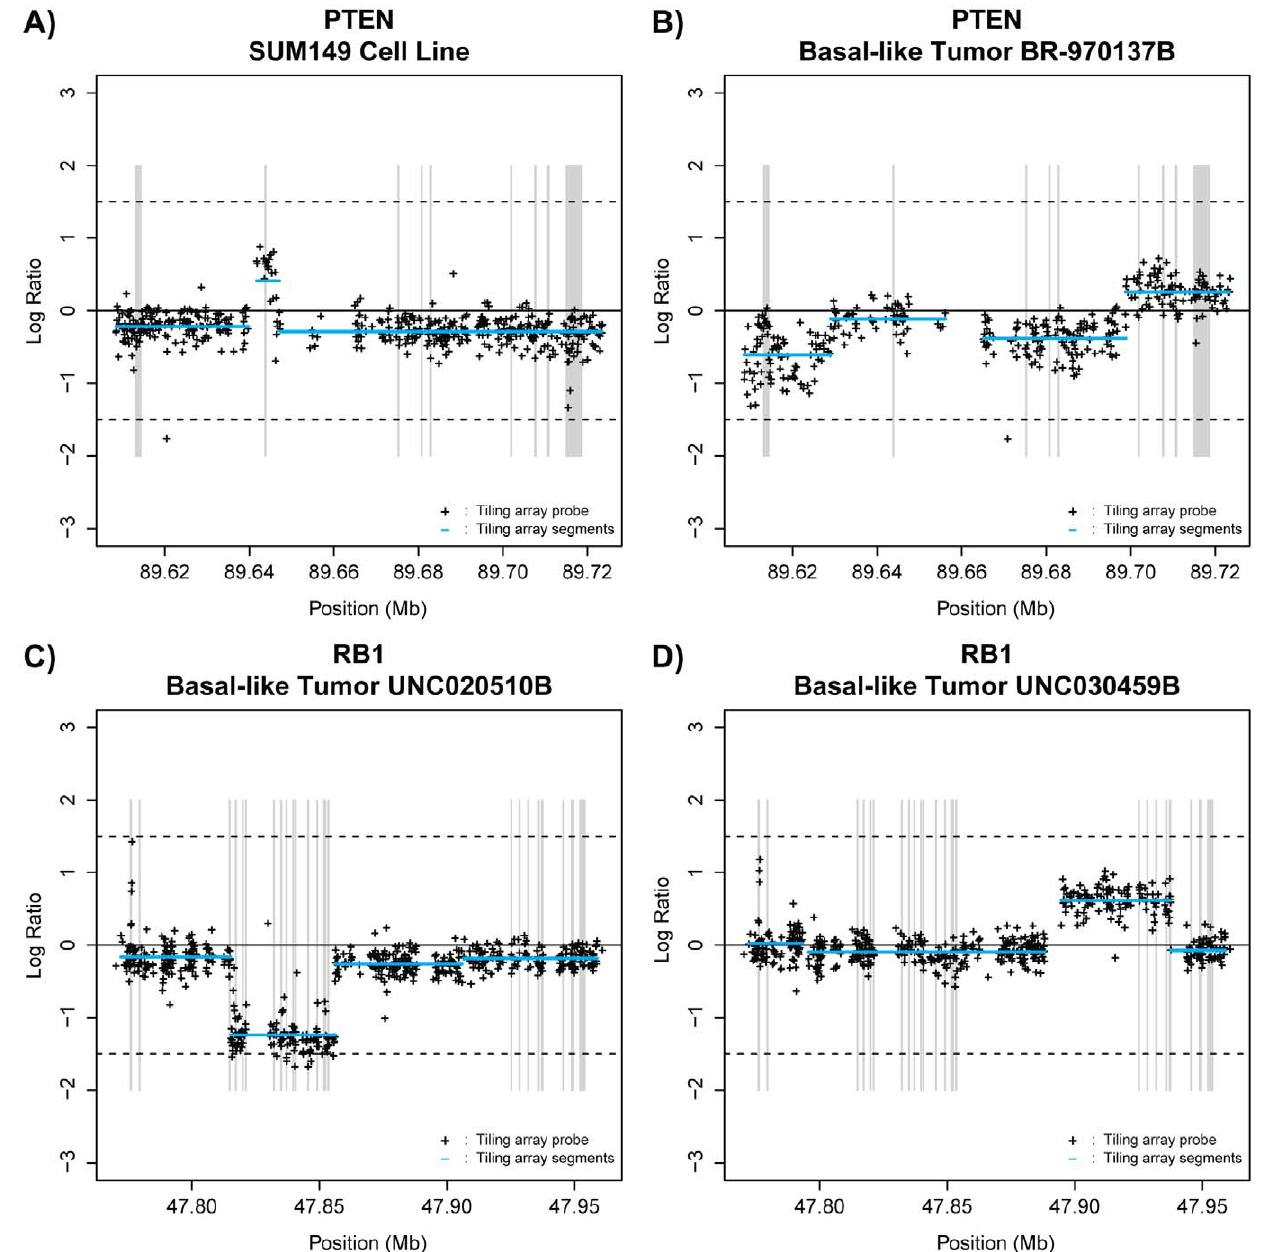
Figure 1. Selected examples of intra-genic micro-aberrations. A) The previously identified PTEN exon 2 micro-amplification in SUM149 cell line DNA. B) Intra-genic deletion in PTEN in basal-like tumor BR-970137B. C) Focal deletion of RB1 in basal-like tumor UNC020510B, and D) amplification of RB1 gene in basal-like tumor UNC030459B. The locations of the tiling array probes are indicated with black crosses. Exons are highlighted with grey bars. SWITCHdna called segments are indicated in